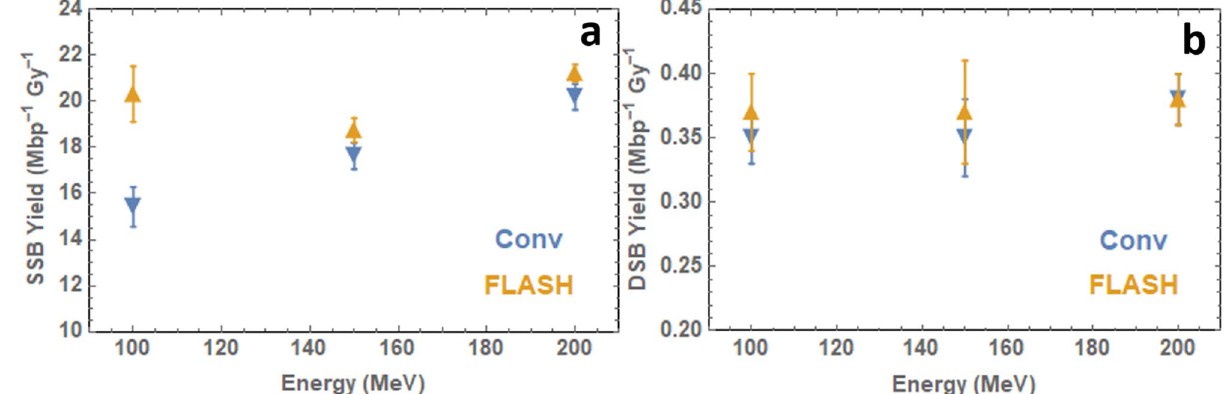
Figure 2. ( a ) Single-strand break yields and ( b ) double-strand break yields for 100–200 MeV electron beam irradiation of wet pBR322 plasmid DNA based on data fitting to the McMahon fit 32 . Plasmids irradiated at Conventional (~ 0.5 Gy/s) and FLASH (> 10 8 Gy/s) dose rates.